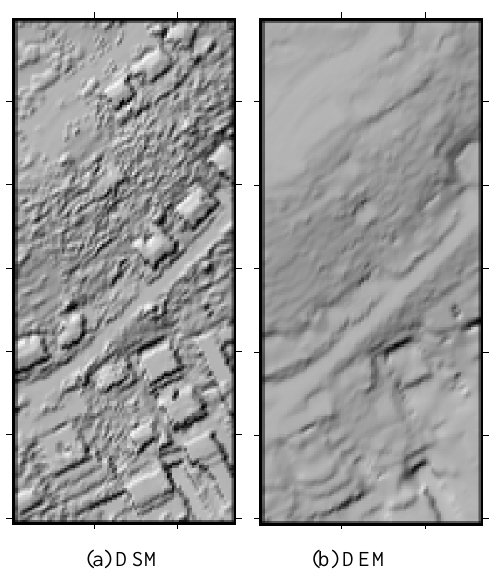
Figure 4. Filtering result of sample 11 Experimental results show that filtering algorithm proposed by this paper is of high adaptability to various scenes including urban and rural areas. Type I error, Type II error and Total error can be simultaneously controlled in a relatively small interval. Figure 2-4 are DSM (Digital Surface Model) generated by raw point clouds and DEM (Digital Elevation Model) generated after filtering of some sample